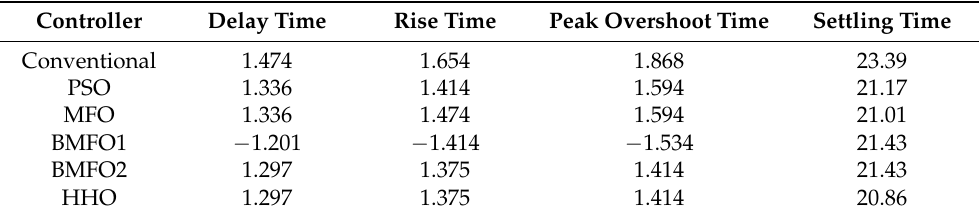
Table 4. Graph analysis of Area2 frequency with various controller under unilateral